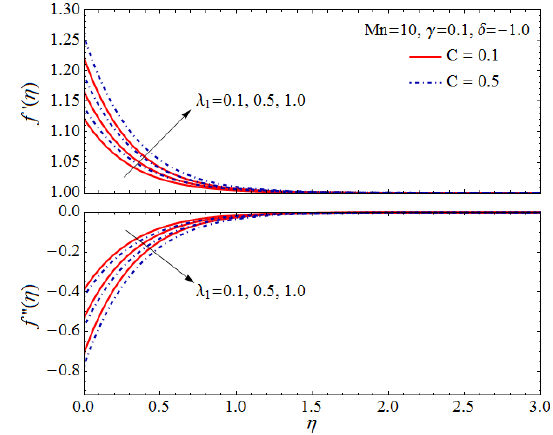
Fig. 6 Dimensionless velocity profile f (cid:48) ( η ) and shear stress profile f (cid:48)(cid:48) ( η ) for various values of δ and C .